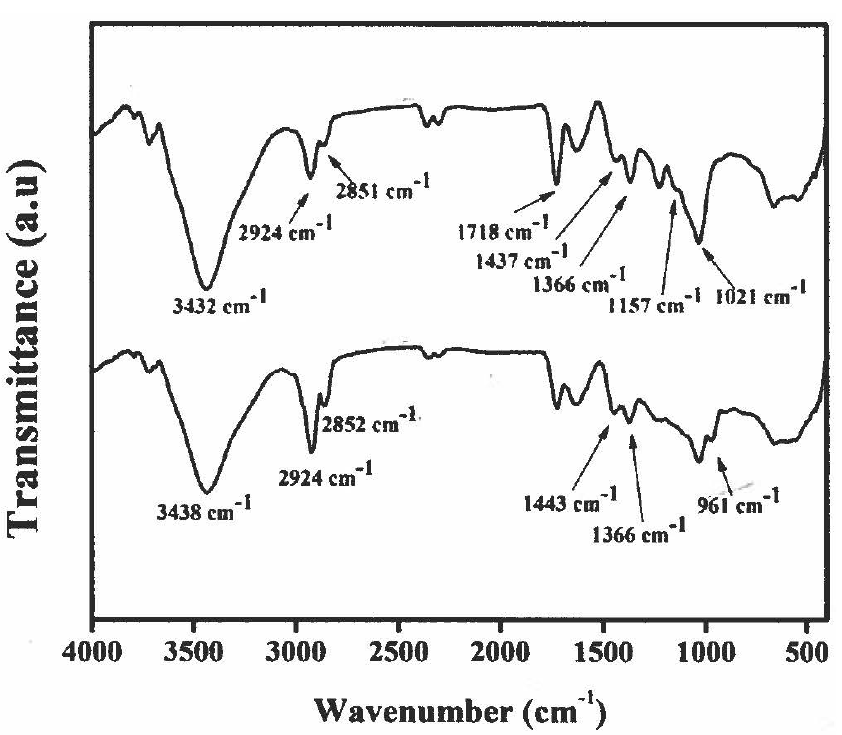
Figure 2. FTIR spectra. (Top) FTIR spectrum of the lutein reference standard. (Bottom) FTIR spectrum of the lutein extract in the microcapsules.